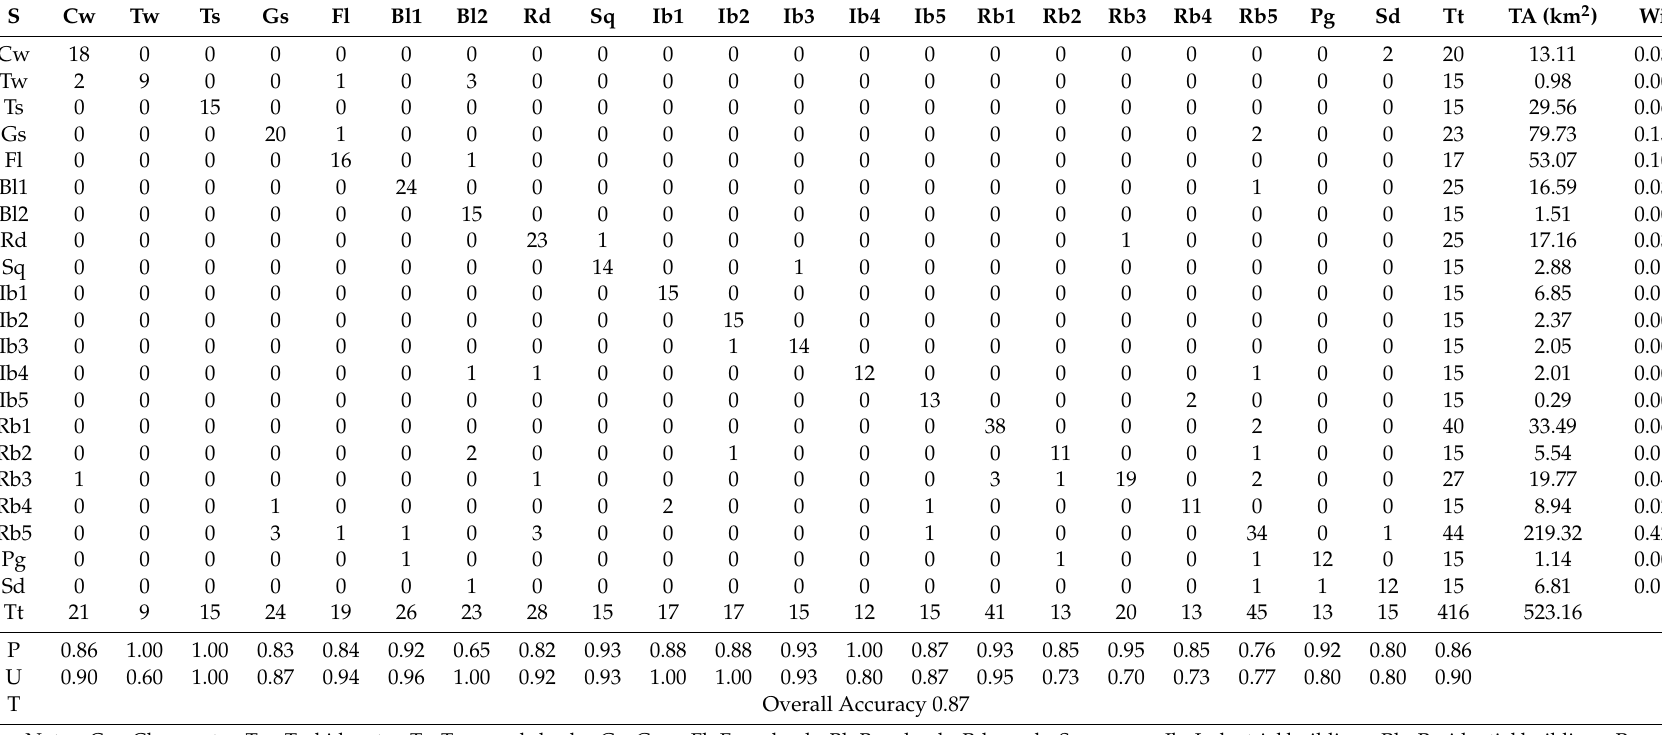
Table A1. Assessment of the land cover map in the third layer of the classification